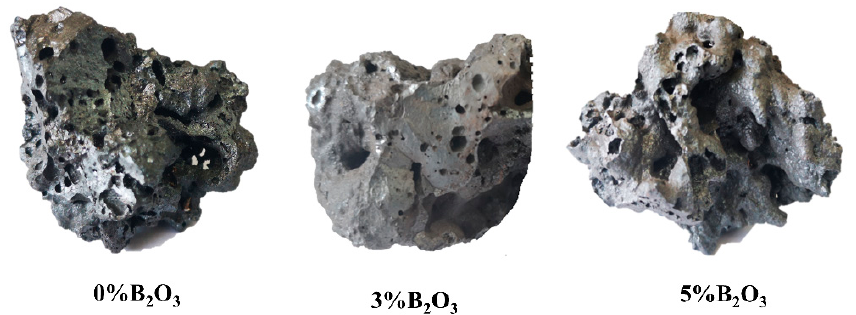
Figure 6. H-VTM sintered ore samples with di ff erent B 2 O 3 addition.